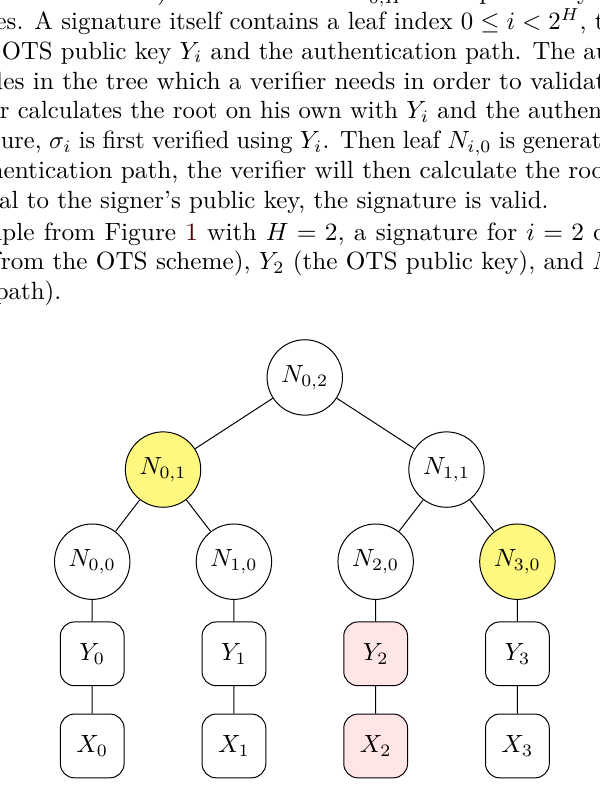
Figure 1: This Merkle tree compresses four OTS public keys into N 0 , 2 . A signature for i = 2 consists of σ 2 , Y 2 , N 3 , 0 , and N 0 , 1